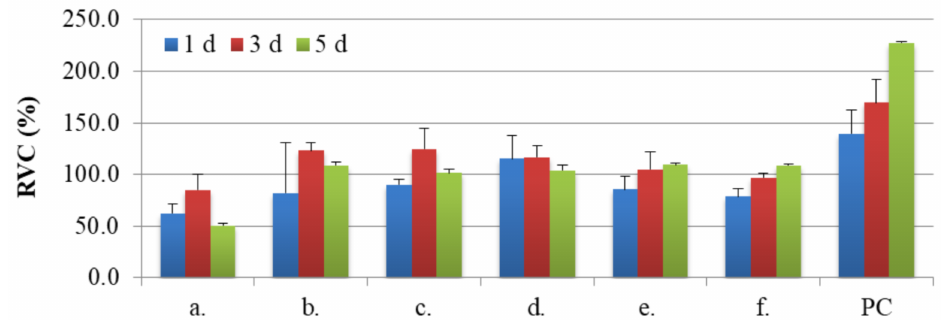
Figure 9. The results of the MTS assays performed at 1, 3, and 5 days on the viability of the osteoblasts for: Ti31Mo ( a ), Ti31Mo after hydrothermal treatment ( b ), Ti31Mo5HA ( c ), Ti31Mo5HA1Ag ( d ), Ti31Mo5HA2CeO 2 ( e ), Ti31Mo5HA2Ta 2 O 5 ( f ); PC—positive control.